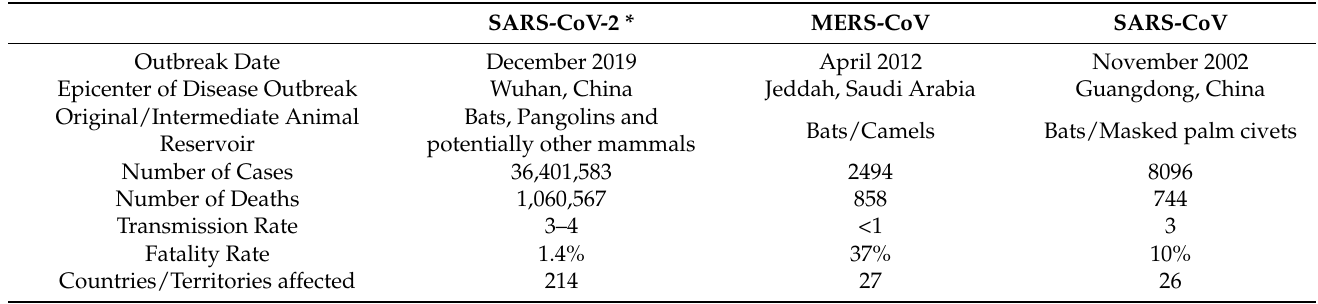
Table 1. Properties of SARS-CoV-2, MERS-CoV and SARS-CoV [8,18,19,30–34]. (* updated as of 8 October